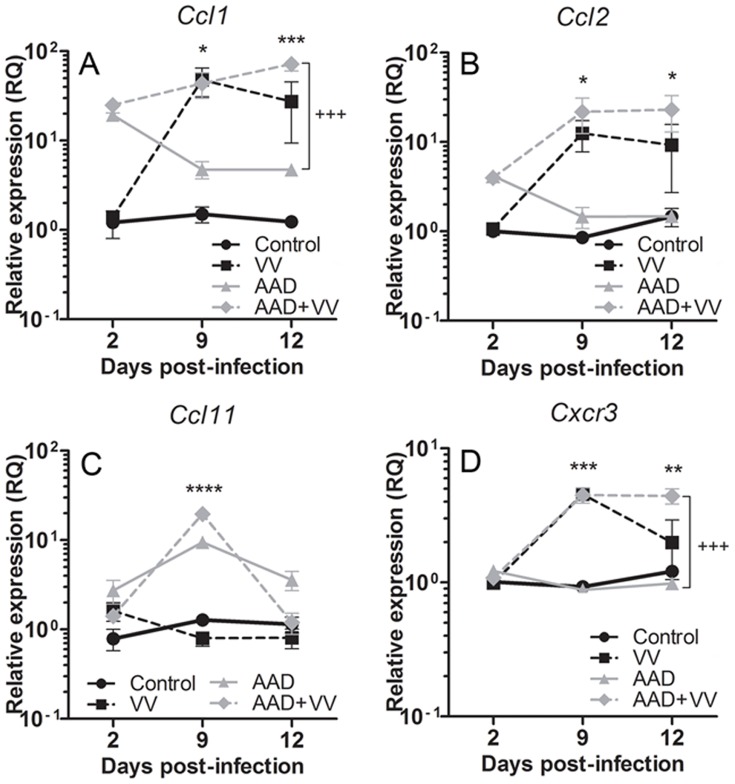
Induction of AAD and pulmonary VV inoculation altered the expression of chemokine ligand and receptor gene transcripts.Relative expression of gene transcripts in lung tissue was measured using qRTPCR. The expression of (A) Ccl1, (B) Ccl2, (C) Ccl11 and (D) Cxcr3 was significantly elevated in VV-infected AAD mice. Data are expressed as the mean relative expression ± SEM for four mice in each group and are representative of 2 independent experiments. Statistical significance was determined by a Two-way ANOVA with Bonferroni’s multiple comparisons test: *P<0.05, **P<0.01, ***P<0.001, ****P<0.0001 AAD+VV vs. control; +++
P<0.001 AAD+VV vs. AAD.